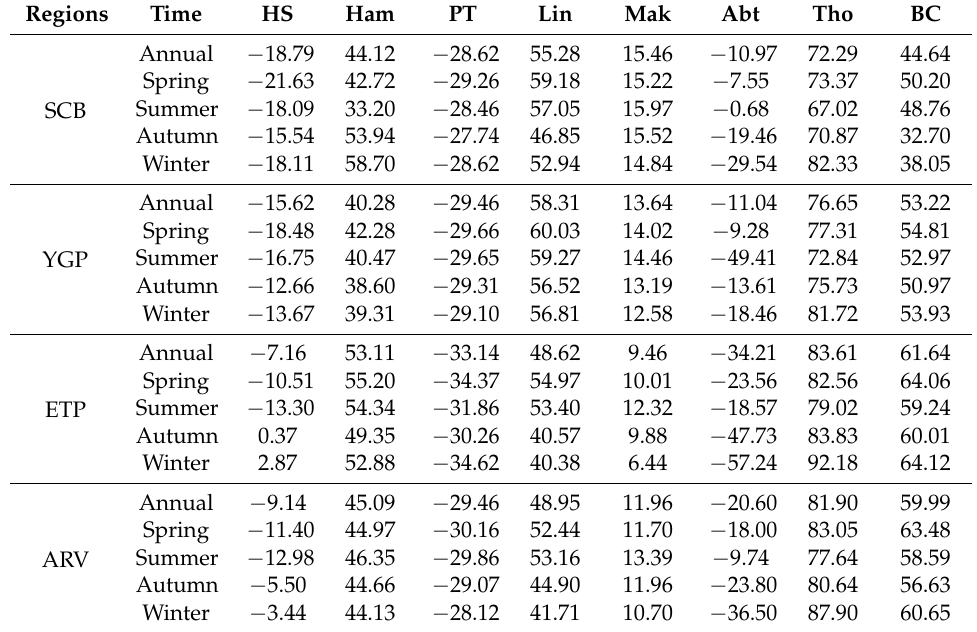
Table 2. Annual and seasonal PBIAS (%) in the four sub-regions a .